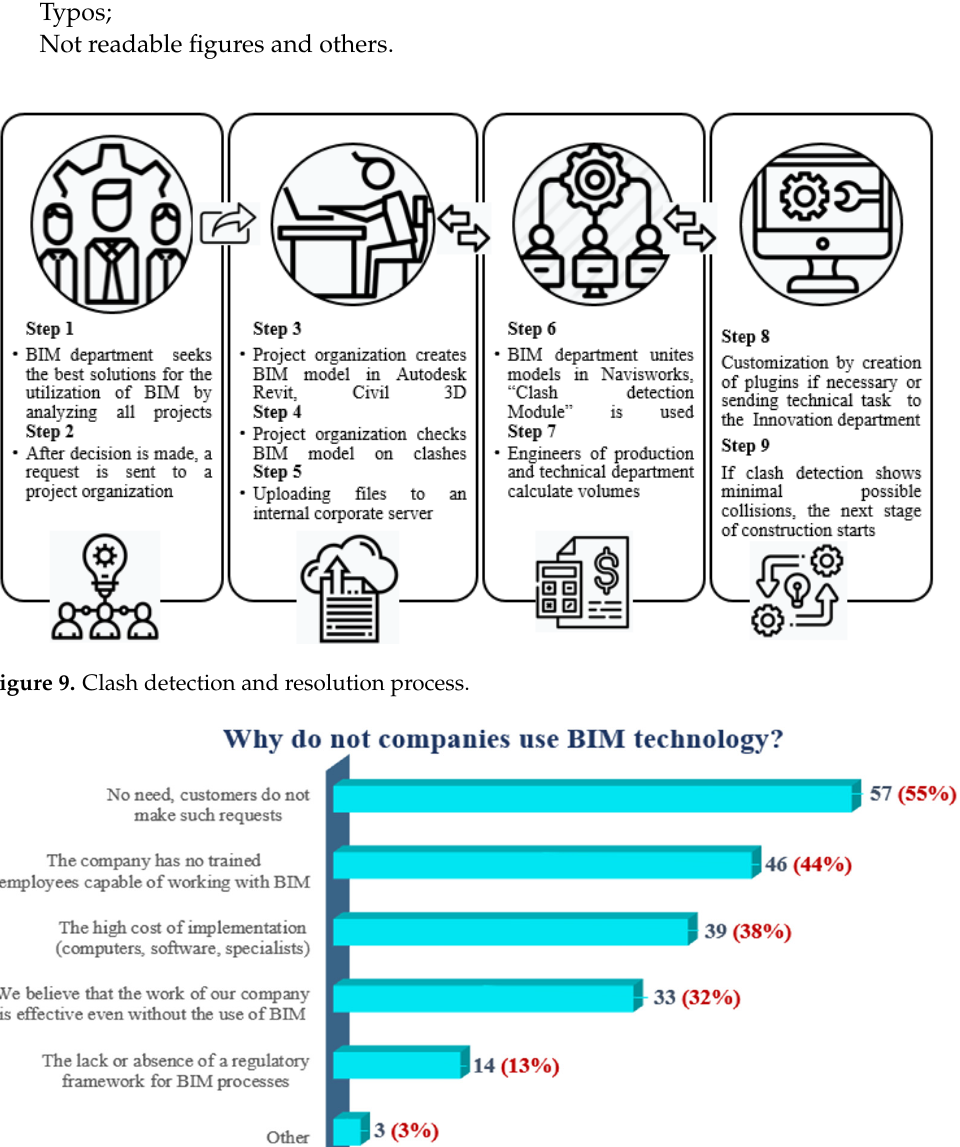
Figure 10. The reasons for refusing to implement BIM among the companies surveyed. (Adapted with permission from ref. [12]. Copyright 2020 National Association of Designers of the Republic of